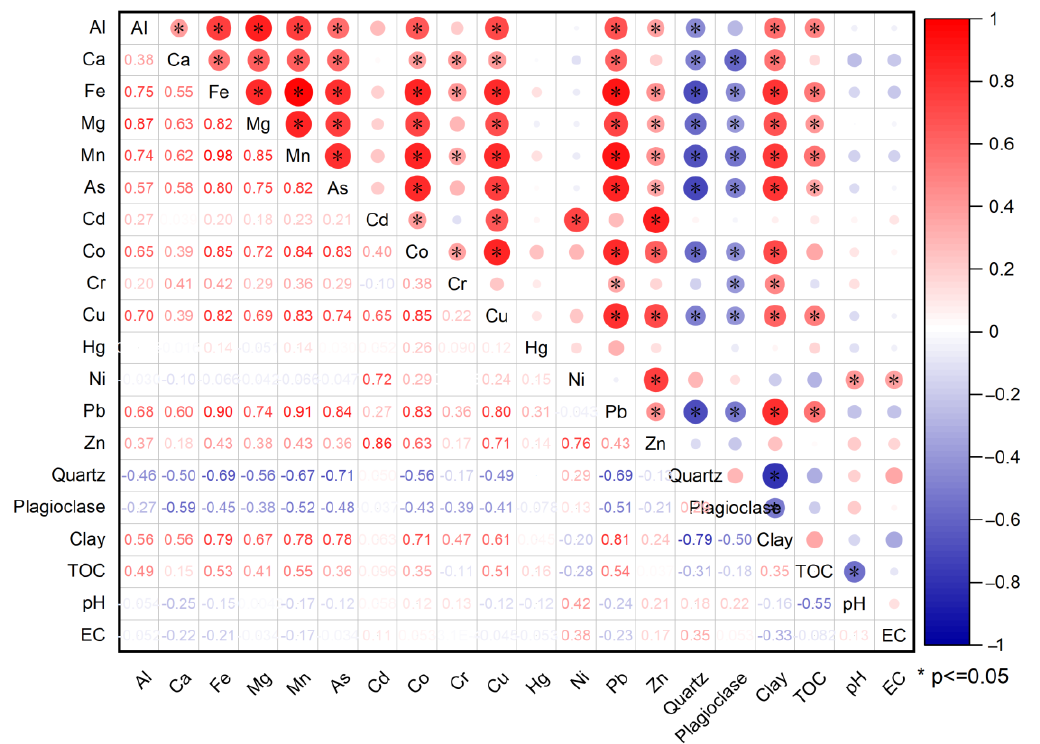
Figure 8. The hot map of correlation between soil heavy metals and influencing factors for the 35 surface soils from Hetao Plain in Bayannur.